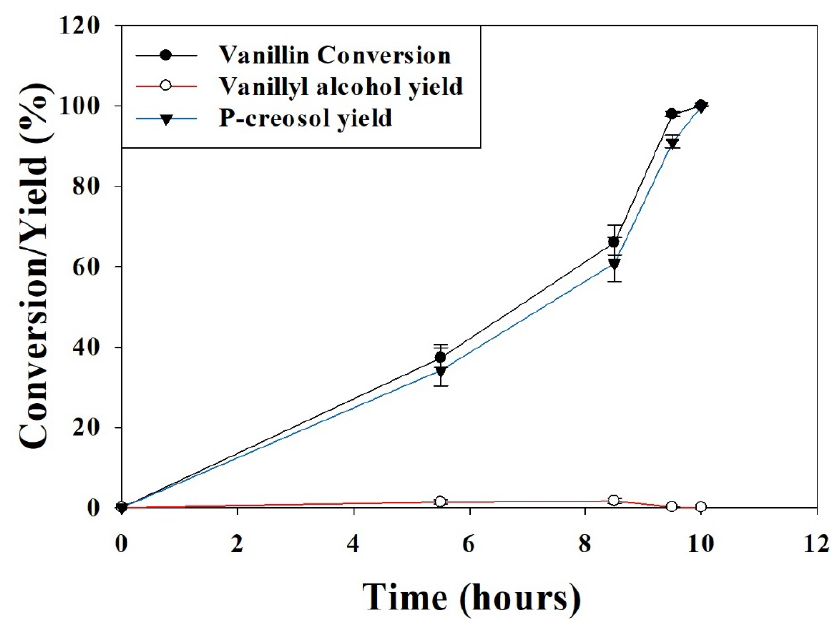
Scheme 1. Reaction pathway for vanillin HDO over Ni/biochar catalyst.